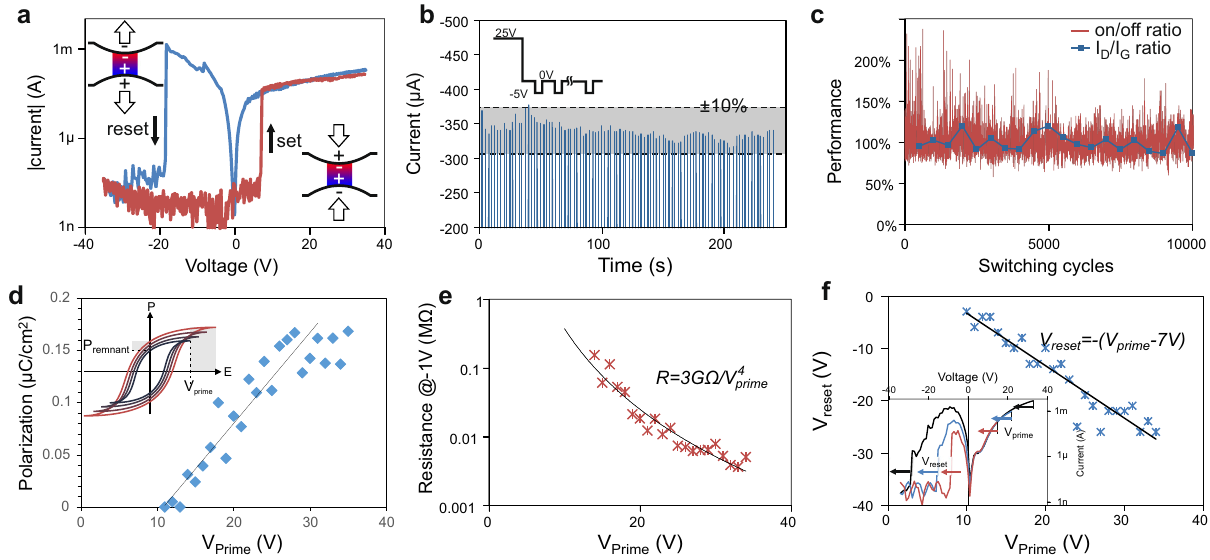
Fig. 4 Nanoelectromechanical memristor. a current-voltage characteristics of a mechanical switch demonstrating a novel bipolar switching behavior, b change of electrical performance (on/off ratio) and defectiveness (Raman I D /I G ratio 32 ) during repeated cycling ( c ) current after single write cycle at 25 V and various delay and read cycles at 0 V and − 5 V, respectively, (inset) representation of pulse sequence, ( d ) remnant polarization as a function of previously applied highest voltage (V prime ), (inset) representation of polarization hysteresis, ( e ) evolution of device resistance depending on previously applied priming voltage, ( f ) change of reset transition voltage as a function of previously applied priming